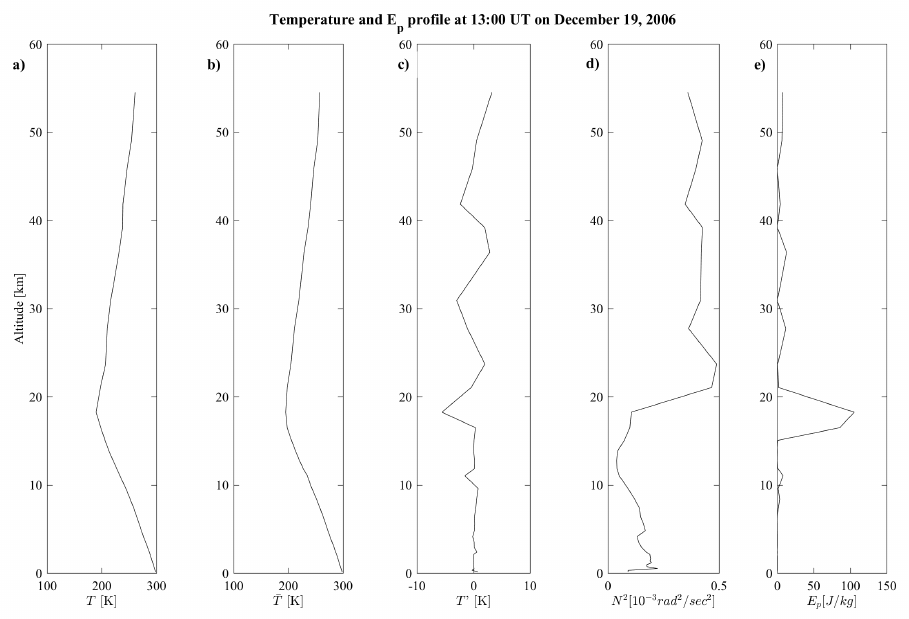
Figure 5. Example of AGW analysis. Vertical profiles of: ( a ) temperature; ( b ) background temperature; ( c ) temperature deviation, ( d ) square term of Brunt − V ¨ ais ¨ al ¨ a frequency, and ( e ) potential energy at 13:00 UT on 19 December